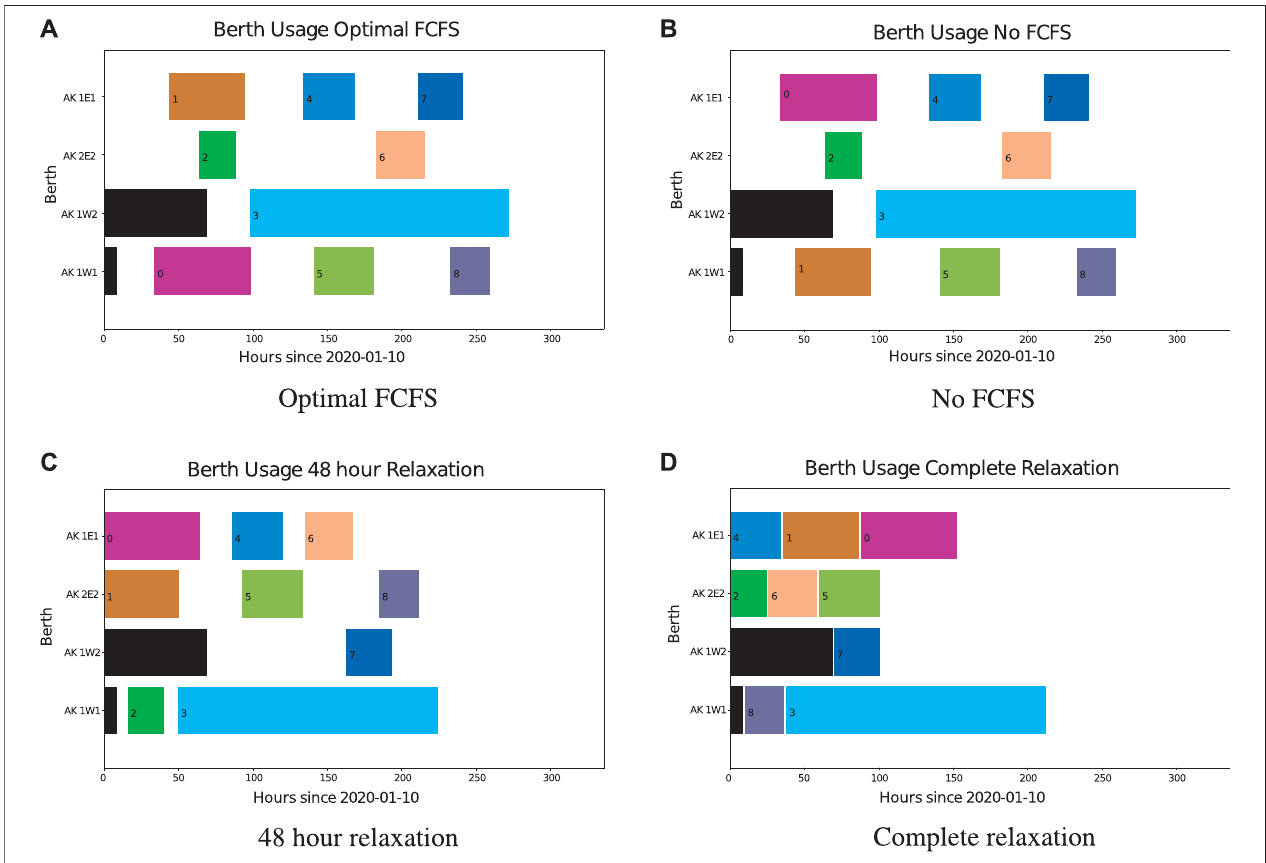
FIGURE 6 | Example schedules of the four different model types for regular sized ships for objective function (cid:1) C j . (A) Optimal FCFS, (B) No FCFS, (C) 48 h relaxation, (D) Complete relaxation.